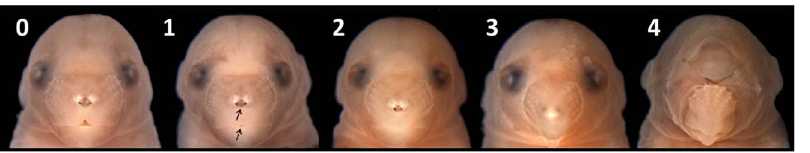
Figure 1. Facial dysmorphology rating scale. Illustrated are a GD 17 fetus having normal facial morphology and 4 fetuses with varying degrees of medial facial deficiency. Numbers assigned to each image (0–4) are scores representing differing degrees of severity of facial dysmorphology. As compared to normal fetuses, those receiving a score of 1 had a notably diminished area of pigmentation between the nostrils (solid arrow) accompanied by reduction in the depth of the normally present median central notch of the upper lip (dashed arrow). A score of 2 was assigned to fetuses that had lost the median lip notch, but still had some remaining pigment at the tip of the nose. Individuals presenting with a single central nostril were assigned a score of 3 and those given a score of 4 had no nostrils.